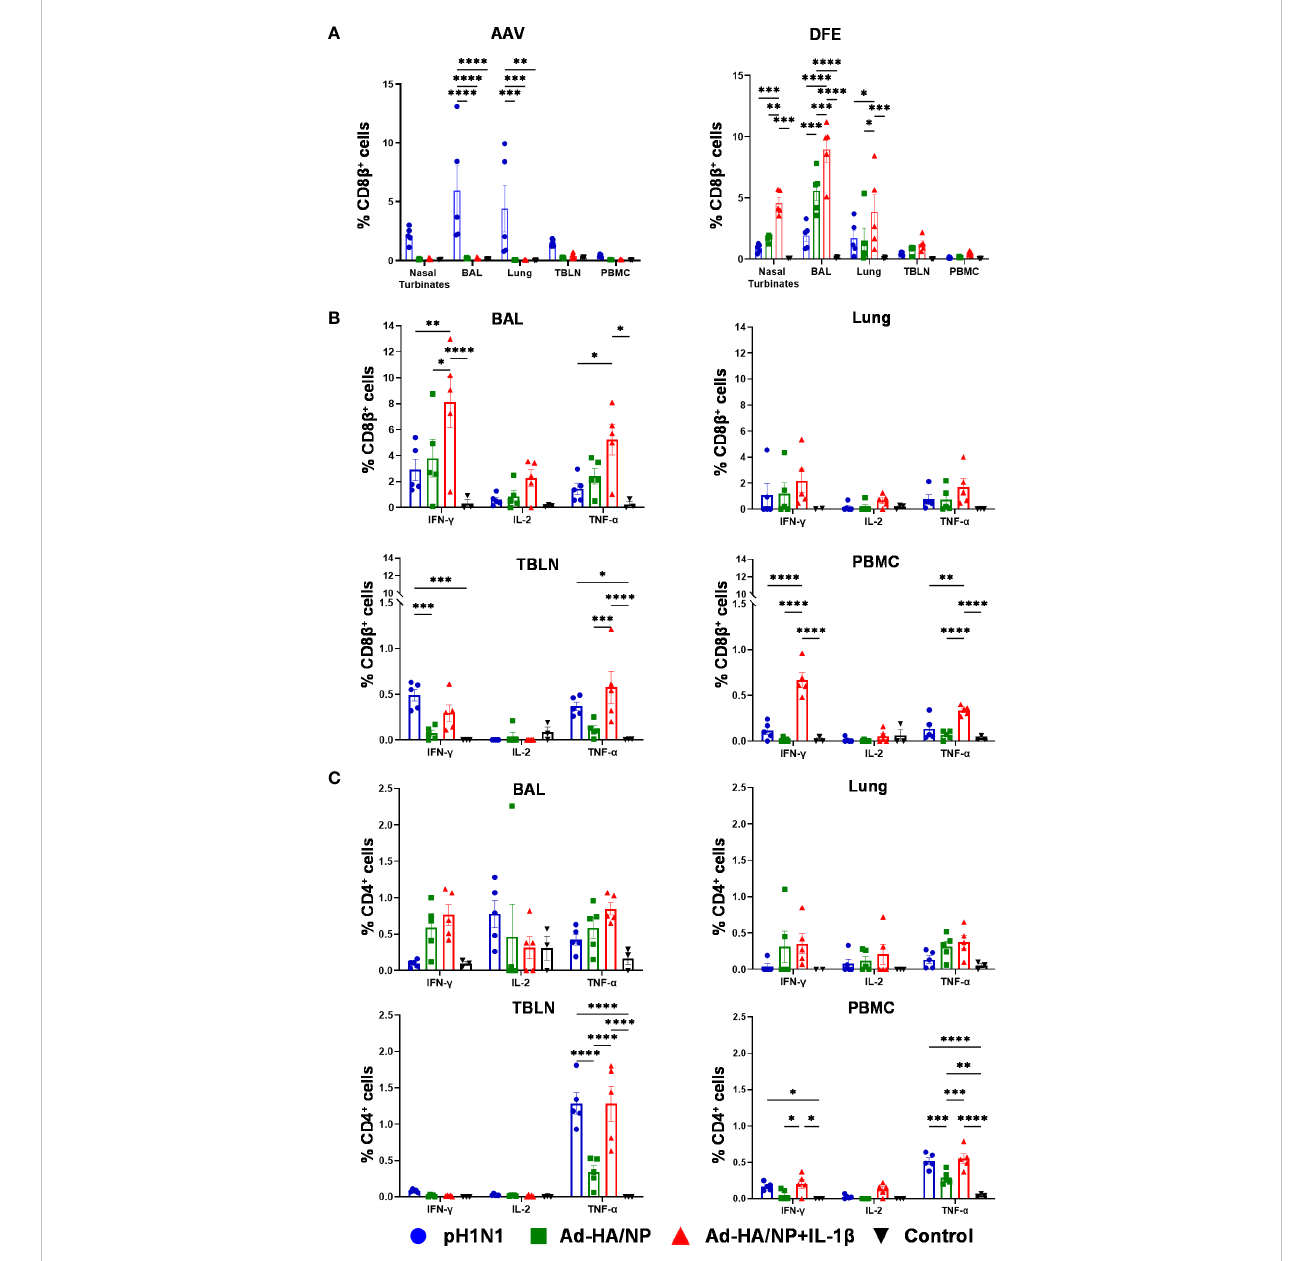
FIGURE 3 Tetramer recognition and functional pro fi le of porcine T cells in different tissues. (A) Proportions of AAV- (left) and DFE- (right) speci fi c CD8 b + T cells in different tissues of pH1N1 infected or Ad-HA/NP ± Ad-IL-1 b immunized pigs at day 21. IFN g , IL-2, and TNF a cytokine secretion were measured by intracellular staining in (B) CD8 + and (C) CD4 + T cells from the indicated tissues at day 21 post-immunization or infection. Statistical signi fi cances were analyzed by two-way ANOVA followed by Tukey ’ s Multiple Comparison Test. Asterisks denote signi fi cance between indicated groups (*, p <0.05; **, p <0.01; ***, p <0.001 and **** p